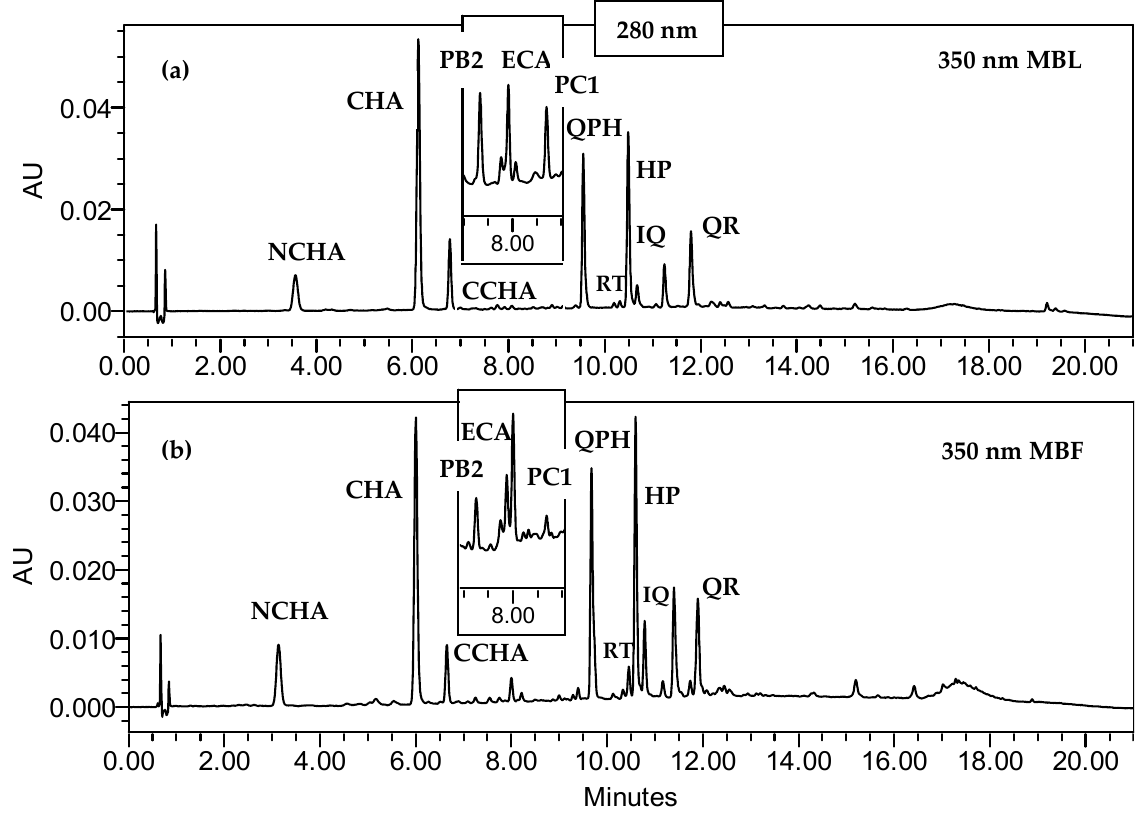
Figure 1. The representative HPLC-UV chromatograms of the methanol–water (7:3, v / v ) extracts from the C. bullatus leaves MBL ( a ) and fruits MBF ( b ); the extract concentrations: 2.20 and 13.29 mg/mL for MBL and MBF extracts, respectively; for details of compound codes, see Table 1. The quantitative profile of polyphenols in the methanol–water (7:3, v / v ) extracts of C. bul- latus , C. zabelii , and C. integerrimus fruits and leaves.